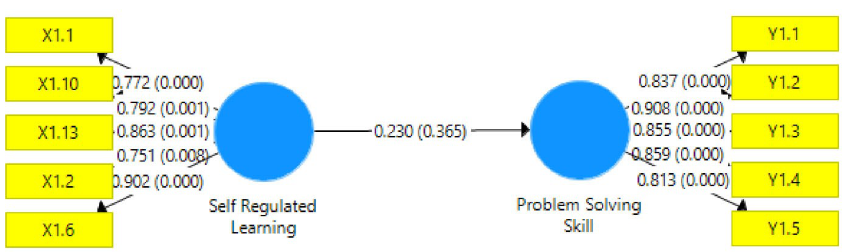
Figure 6. New structural model and SEM-PLS analysis results